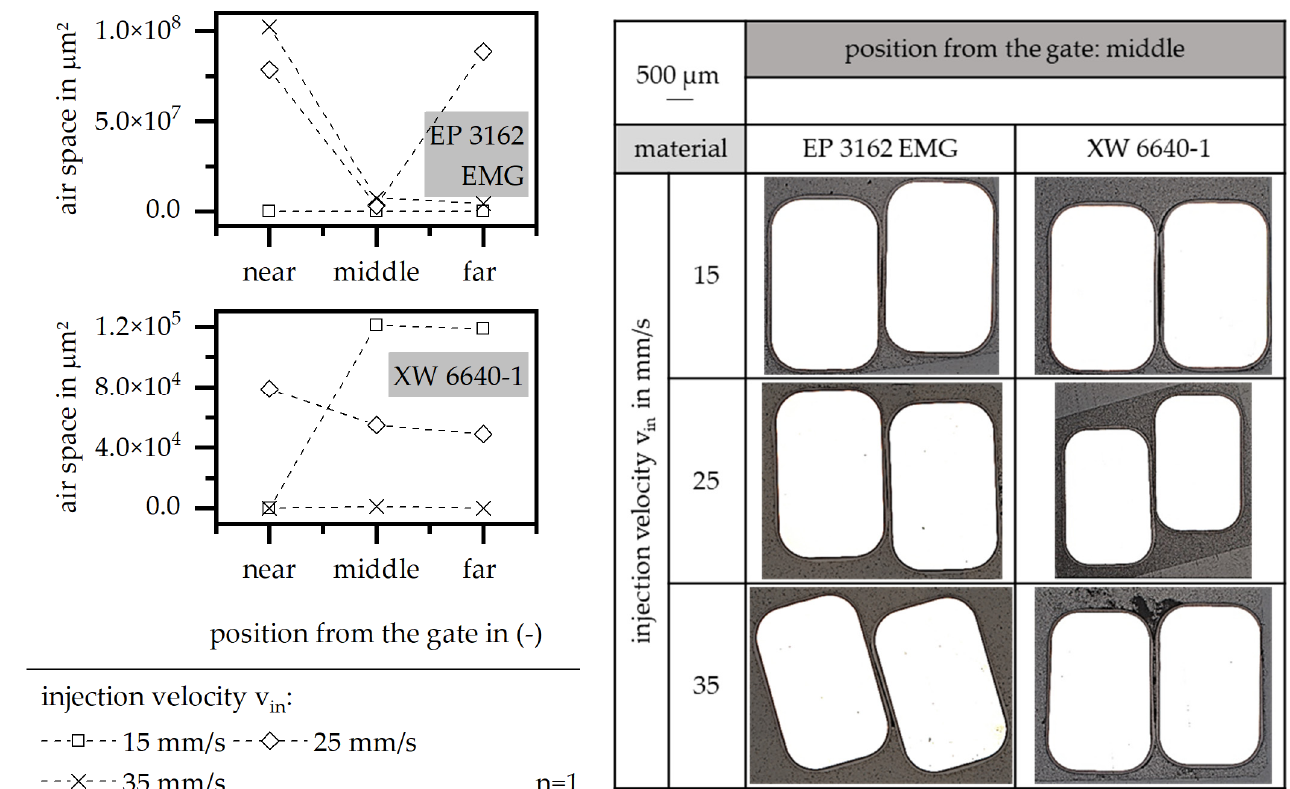
Figure 14. Airspace and position of the wire relative to the stack, relative to the injection velocity in the insulation system.